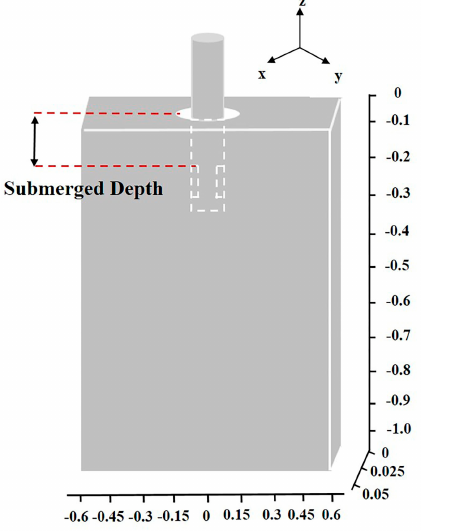
Figure 3. Schematic of mold water model: ( a ) mold size and ( b ) submerged entrance nozzle size.